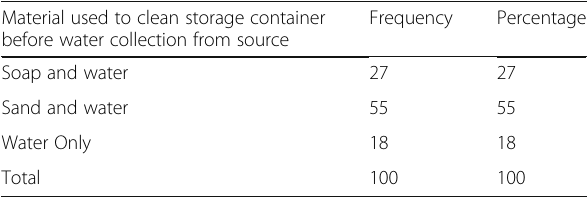
Table 4 Materials used to clean storage containers by household before water collection from